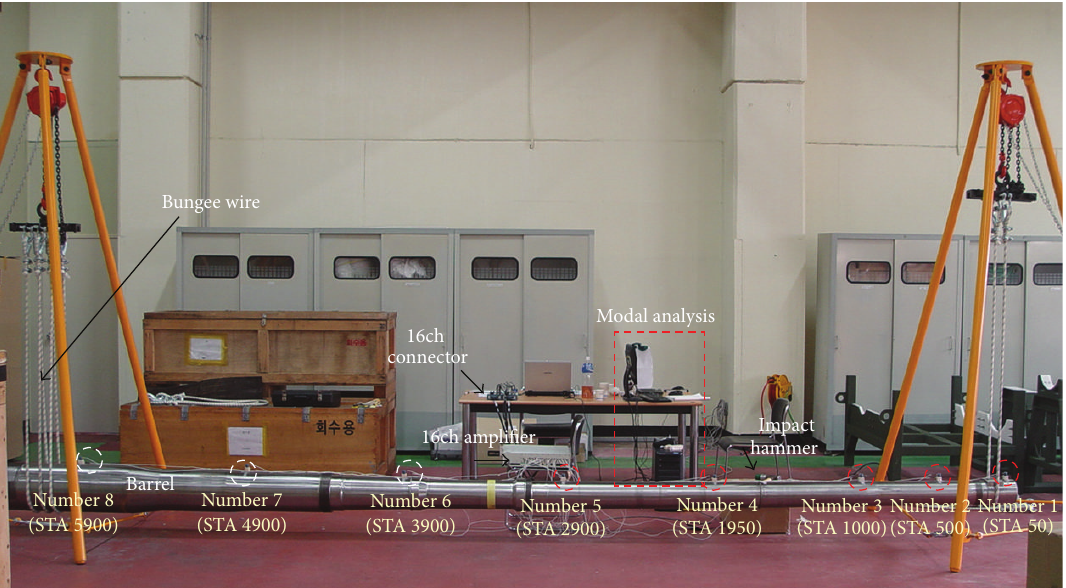
Figure 9: Experimental setup of bungee test.